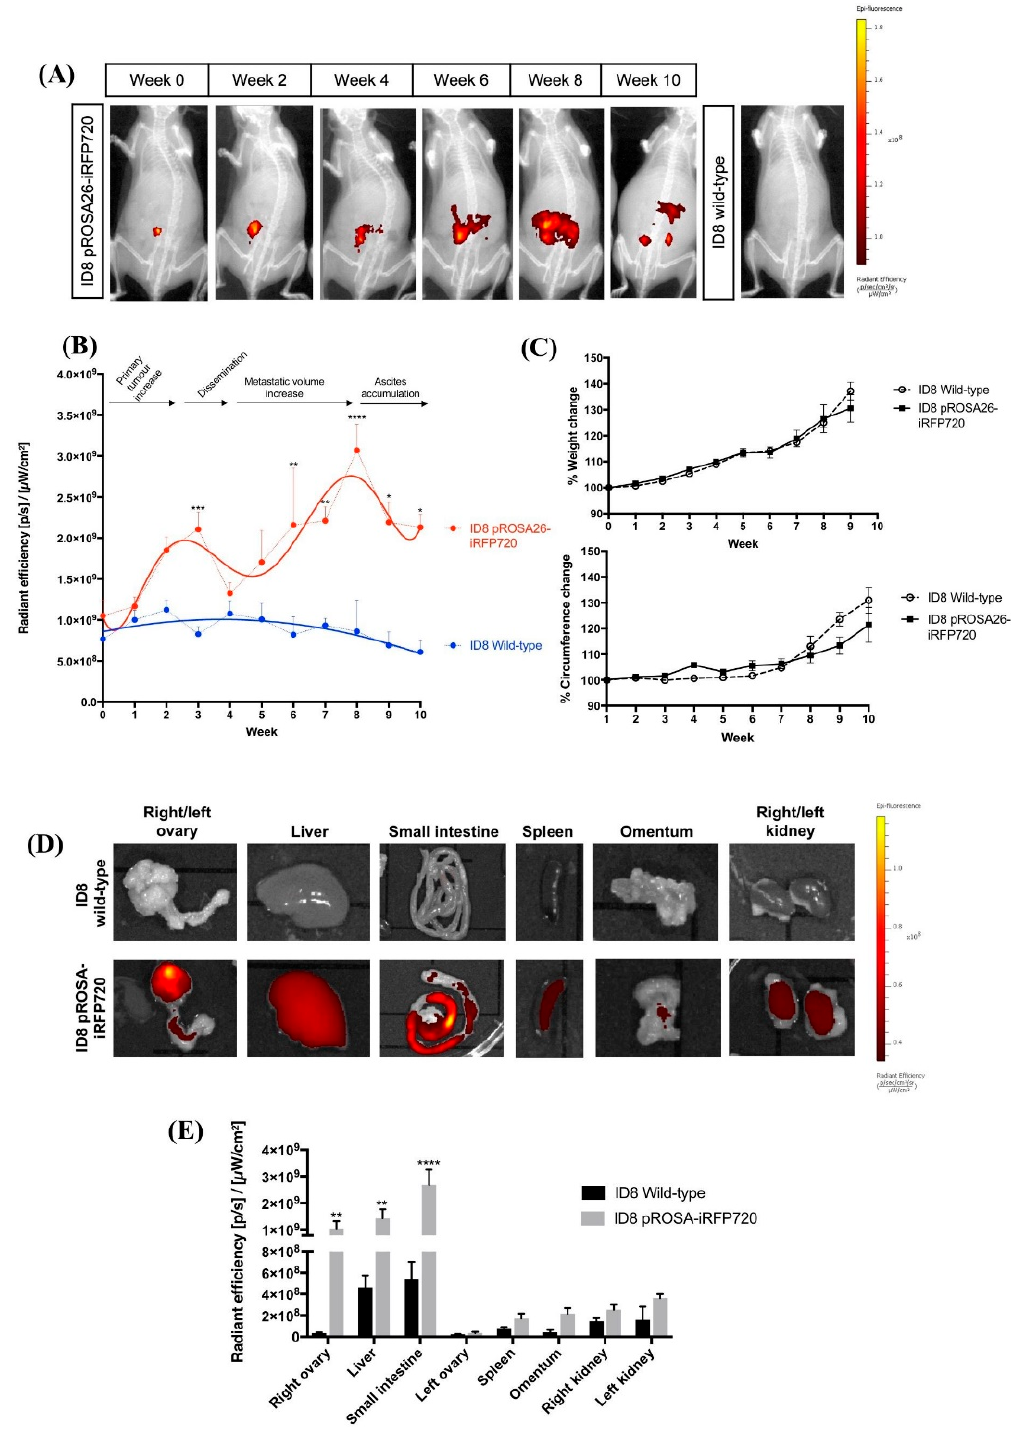
Figure 3. In vivo tracking of iRFP720 fluorescence in real time. ( A ) pROSA-iRFP720 or wild-type ID8 cells (1 × 10 6 cells/mouse) were implanted into the ovarian bursa and iRFP720 fluorescence was measured using the IVIS Lumina III In Vivo Imaging System (Perkin Elmer, MA, USA). Mice were imaged at field of view (FOV) C ( n = 4–16) and iRFP720 fluorescence was detected using the iRFP filter set at an exposure time of 5 s. The iRFP signal was isolated using a custom spectral unmixing algorithm. Representative images are shown. ( B ) Quantitative region of interest (ROI) analysis of iRFP total radiant efficiency (p/s)/(µW/cm 2 ) over time. ( C ) Average weight and circumference of mice over time following tumour implantation ( n = 4–16). ( D ) Representative images of iRFP720 fluorescence in excised organs post-mortem at the humane endpoint. ( E ) Quantitative ROI analysis of excised organs indicating iRFP total radiant efficiency (p/s)/ (µW/cm 2 ) ( n = 4,5). *, p <0.05; **, p < 0.01; ***, p <0.001; ****, p < 0.0001.